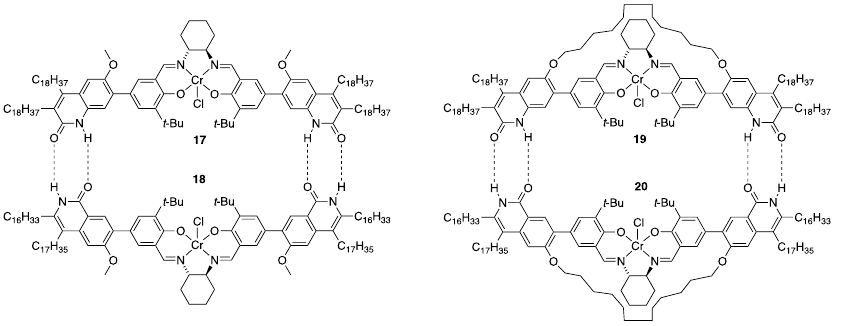
Figure 5. Monomeric catalysts 17 – 20 , drawn as hydrogen-bonded cyclic dimeric aggregates.